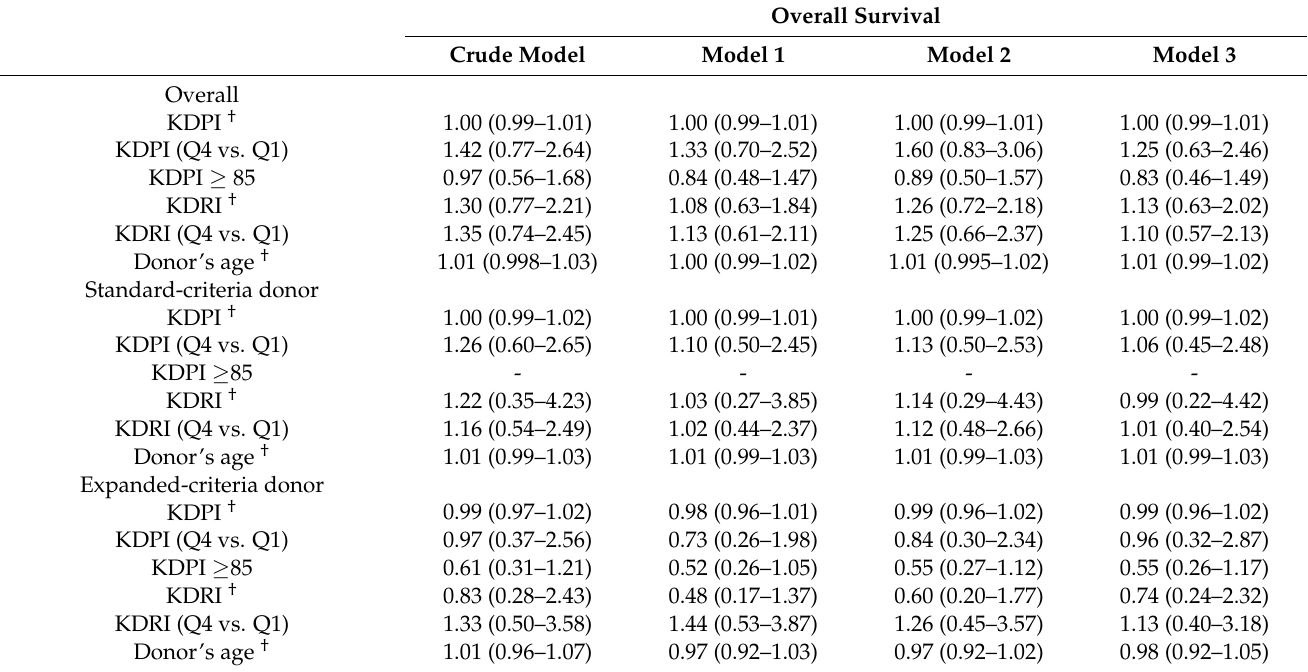
Table A2. Cox proportional hazards regression analysis evaluating the effects of KDPI, KDRI, and donor’s age on overall patient survival.